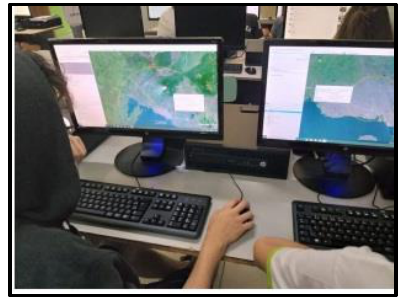
Figure 9. Story Map - We are all Refugees: the story of children from Democratic Republic of Congo .